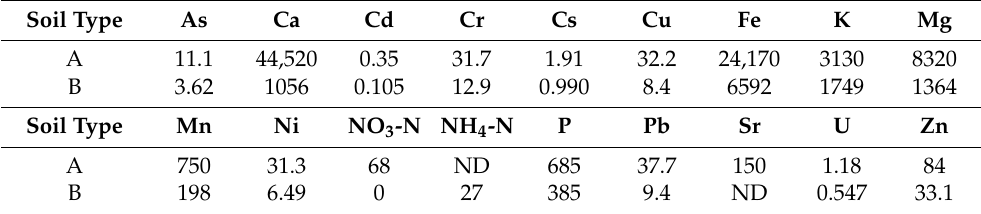
Table 1. Mean values soil mineral concentrations (mg kg − 1 by dry weight (DW)).